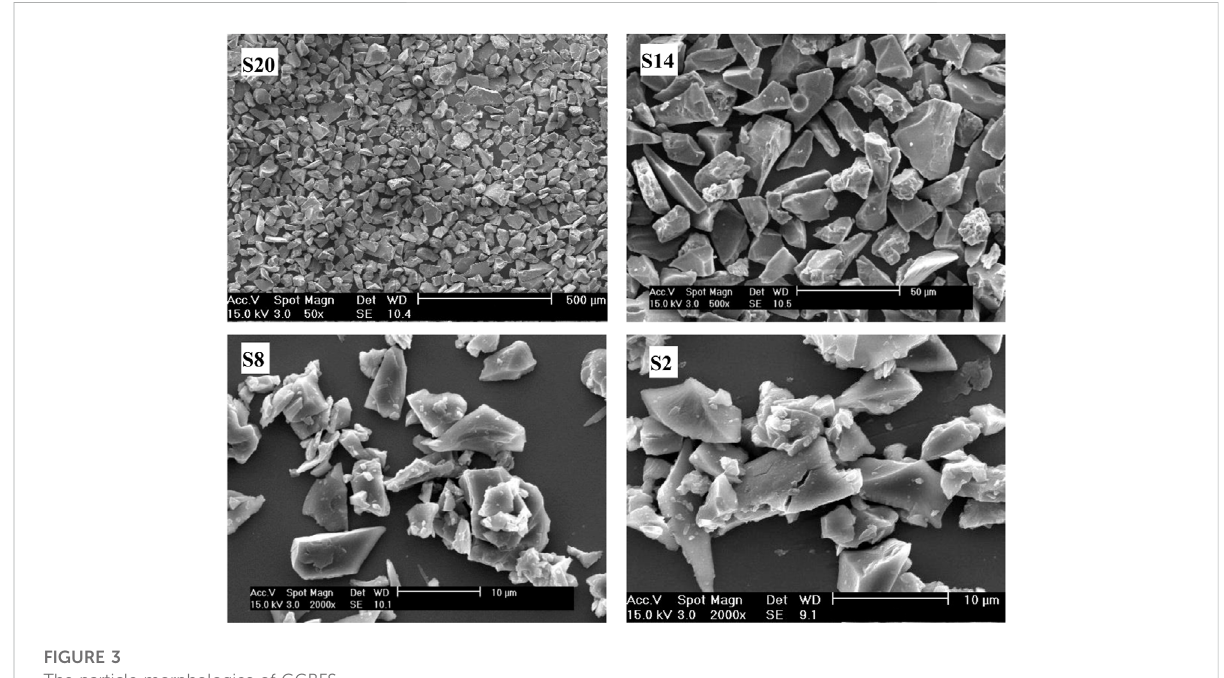
FIGURE 3 The particle morphologies of GGBFS.